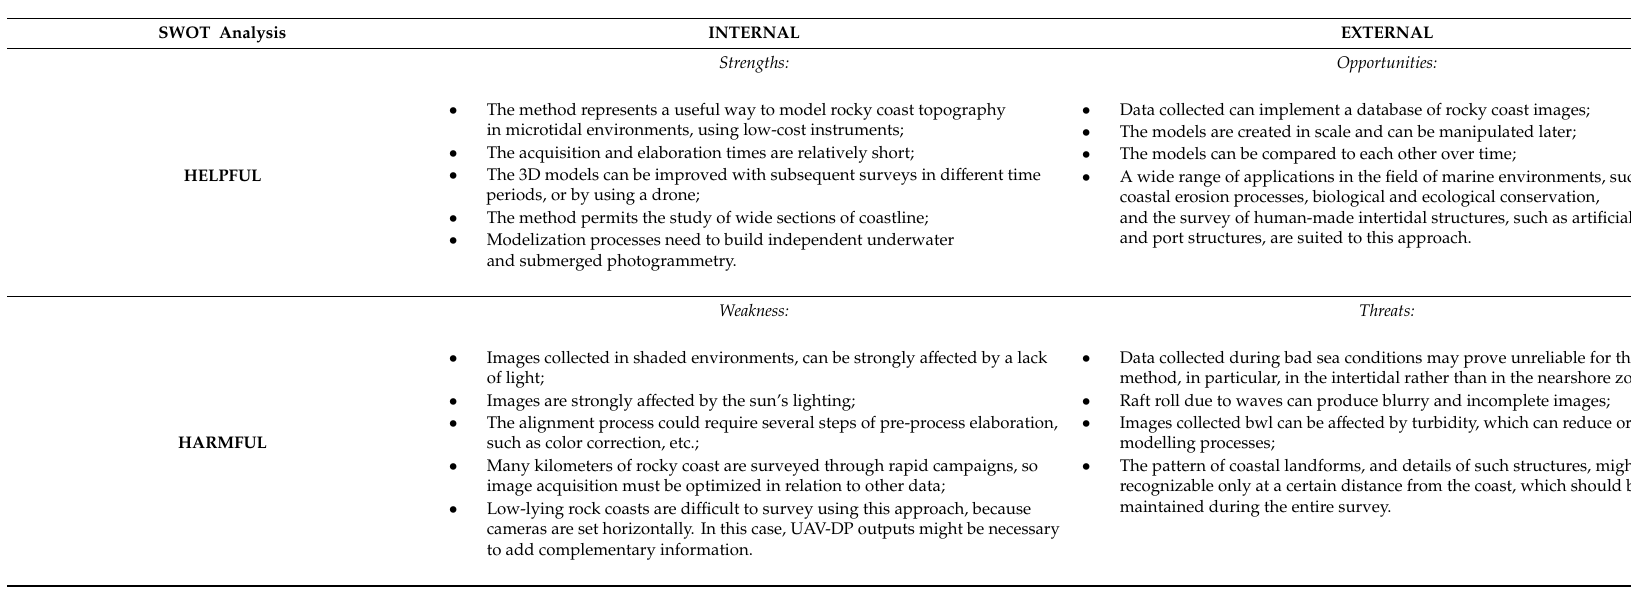
Table 8. The SWOT matrix. This analysis of the strengths allows for the definition of the characteristics of the method that give an advantage over other approaches of coastal modelling; the weaknesses allow for the definition of the characteristics of the approach that need improvements; the opportunities define the goals, or the elements that the project could exploit to its advantage, while the threats analyze the overall obstacles to using the